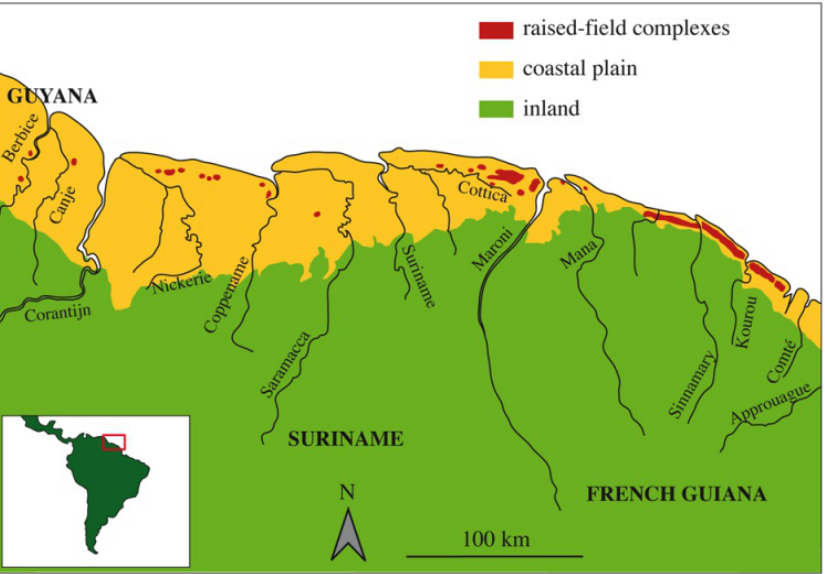
Figure 5. Map of the raised-field complexes of the Guianas